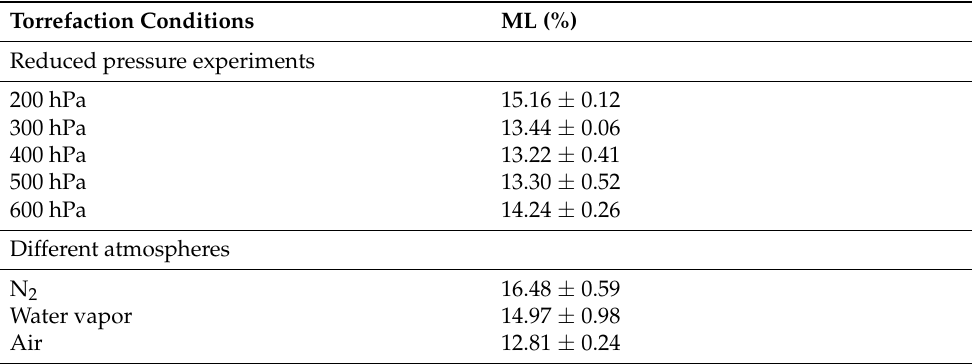
Table 1. ML of poplar wood samples for each treatment employed. Torrefaction